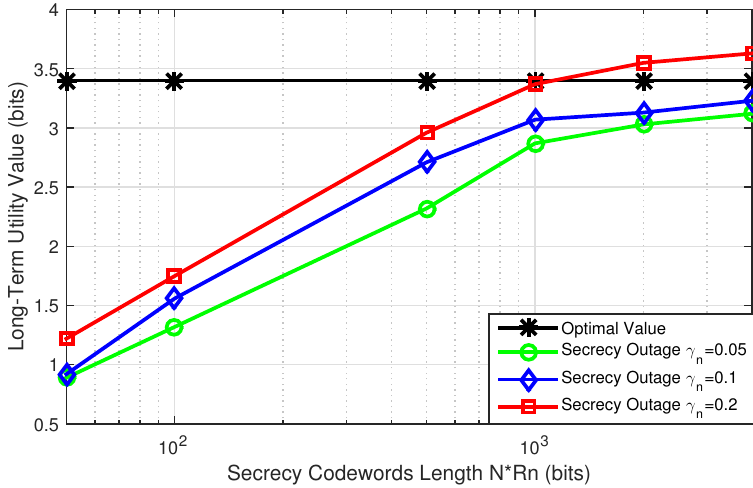
Figure 5. Long-term utility with varying secrecy codeword length.